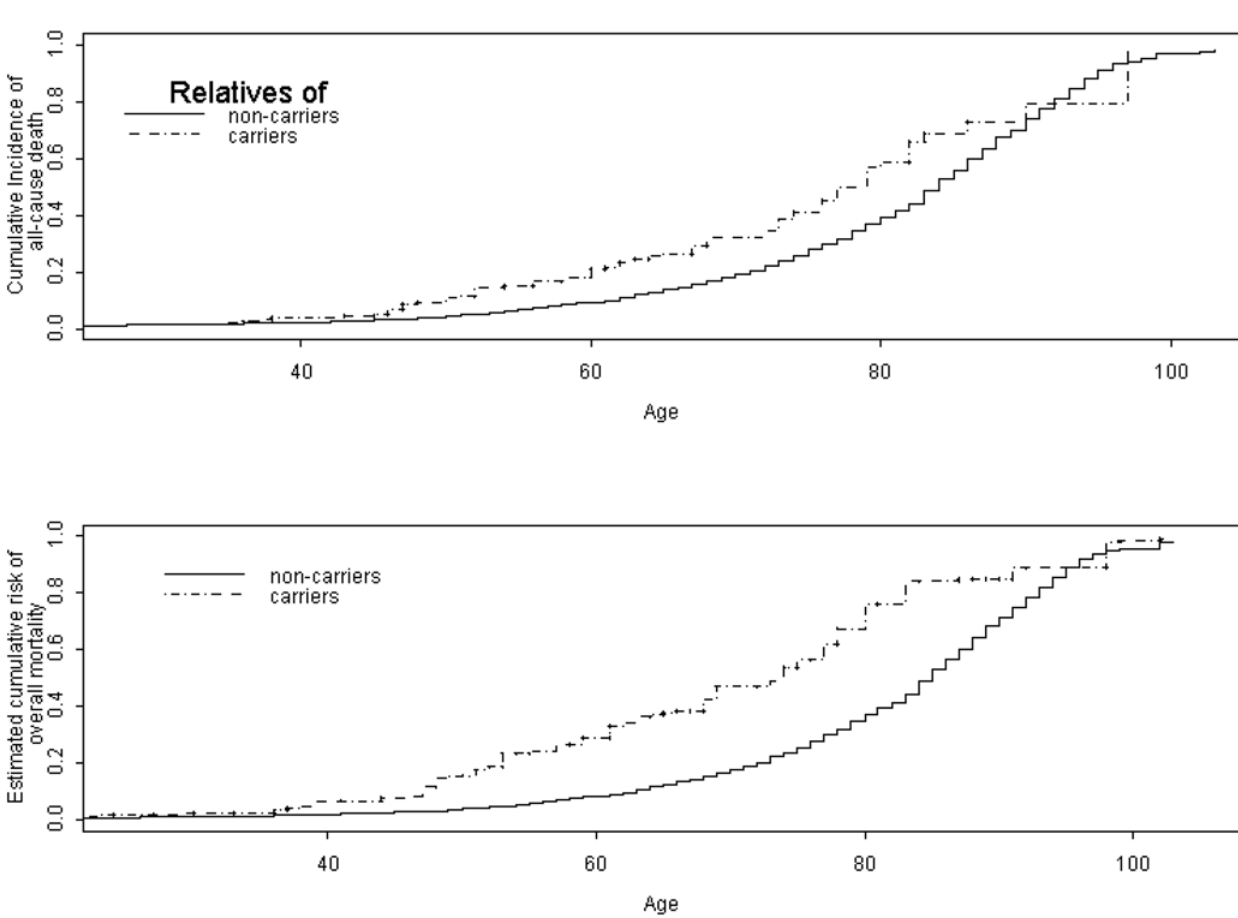
Figure 1. Cumulative incidence of all-cause mortality. Panel 1 shows the cumulative incidence of all-cause mortality among female first- degree relatives of participants in the Washington Ashkenazi Study. Panel 2 shows the corresponding kin-cohort estimate of cumulative mortality risk among female carriers and non-carriers of BRCA1/2 Ashkenazi Jewish founder mutations. doi:10.1371/journal.pone.0004812.g001 PLoS ONE |